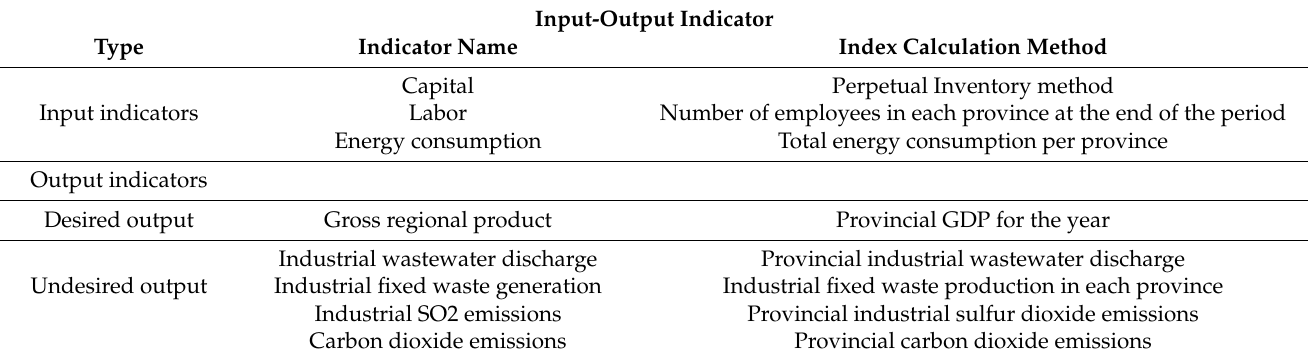
Table 1. Description of input–output